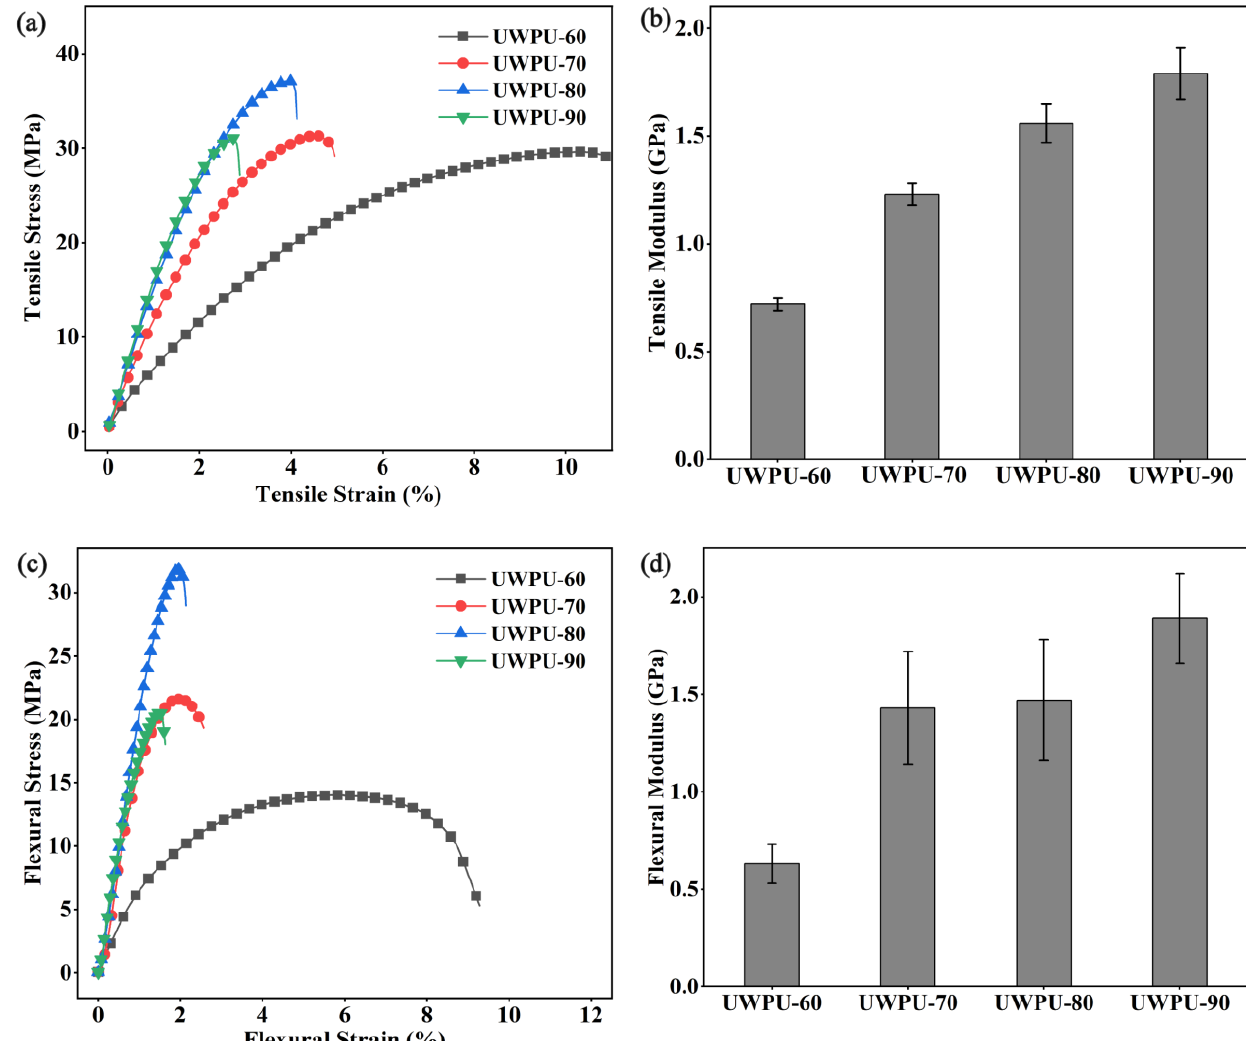
Figure 4. Mechanical properties of UWPU composites: ( a ) tensile stress – strain curves; ( b ) Young’s modulus; ( c ) three-point flexural stress – strain curves; ( d ) flexural modulus.